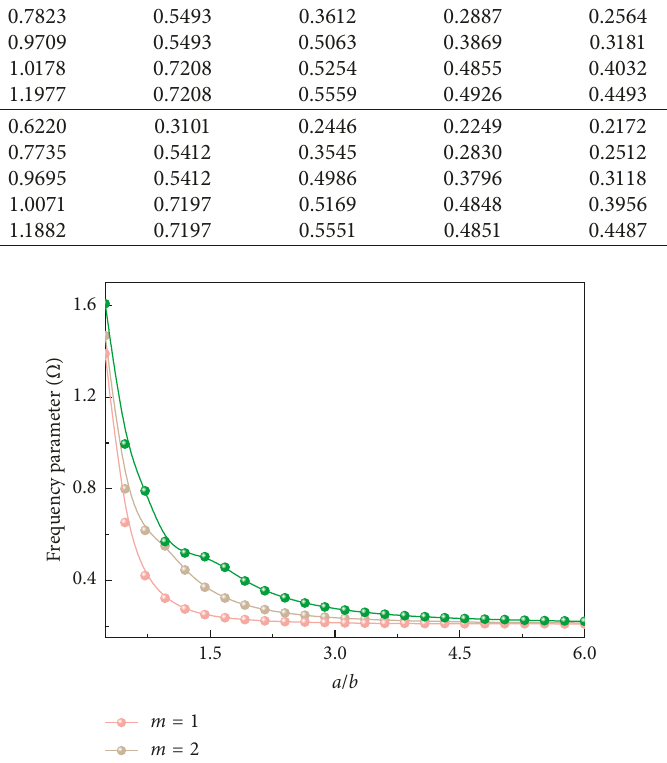
Figure 5: Nondimensional frequency parameter of type I porous rectangular plates with different aspect ratios